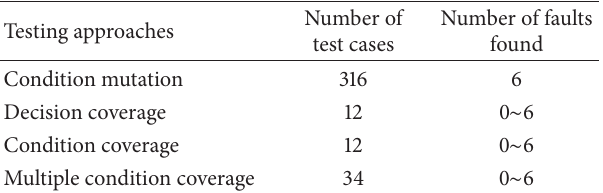
Table 5: The comparison with related testing approaches.